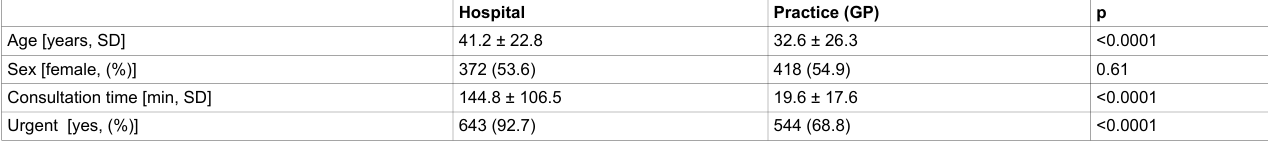
Table 2: Patient and emergency care characteristics, differentiated by GP and hospital cases, and statistical significance (continuous data: wilcoxon, for sex and urgency chi 2 -test). Data are presented as means and standard deviations (SD) if they are continuous and in numbers and percentages, if they are binary,